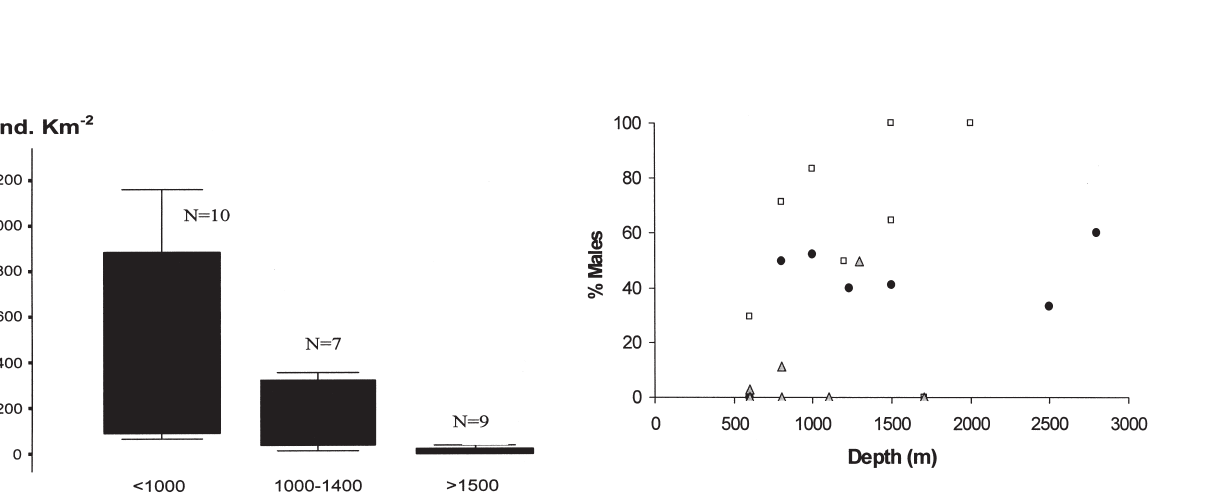
F IG . 5. – Percentage of males by depth for the three sampling areas. Circle, Balearic Sea; square, western Ionian Sea; triangle, eastern Ionian Sea. F IG . 4. – Box-plot diagram for the Kruskal-Wallis significance test for the depth ranges compared for all samples combined ( X 2 = 14.645; p < 0.05). Thick black line, average; rectangle, 75% of the standard deviation; horizontal lines, standard deviation. N, number of samples